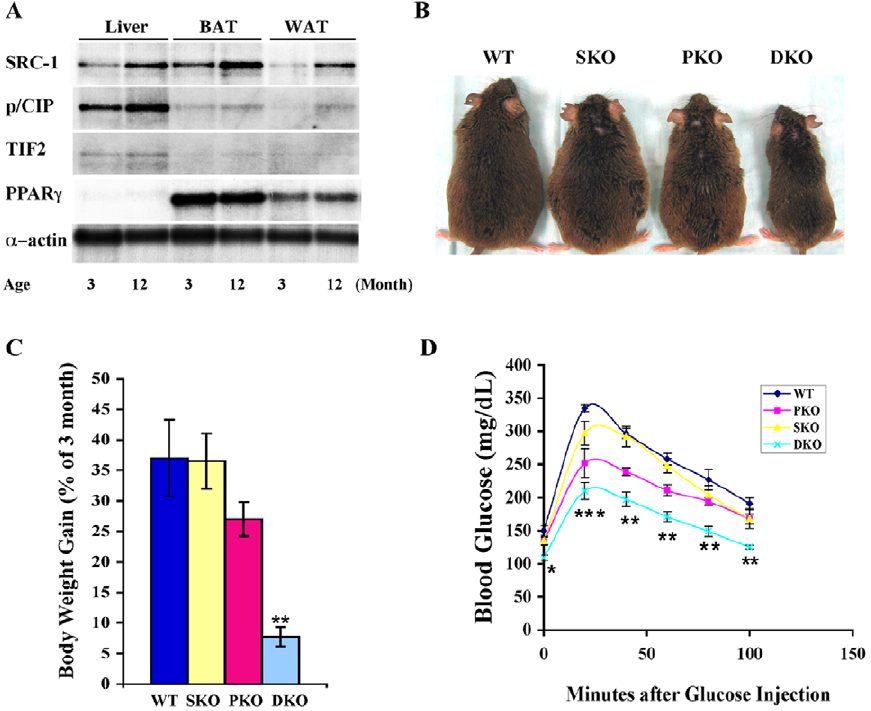
Figure 5. The DKO mice are resistant to age-related obesity and glucose intolerance. A. Northern blot analyses were performed to detect changes in p160 coactivator levels from 3 to 12 month old wild-type male mice. B. DKO mice remain lean at 12 months of age while the littermates become obese. C. Body weight gain is presented based on initial body weight of 3 month old male mice. D. GTT was performed with 12 month-old and sex-matched mice (5 for each genotype). * p , 0.05, ** p , 0.005, and *** p , 0.0005.